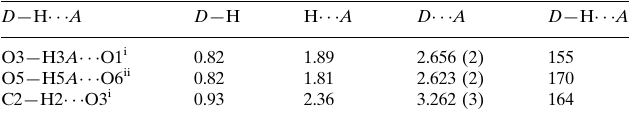
Hydrogen-bond geometry (A˚ , (cid:2)